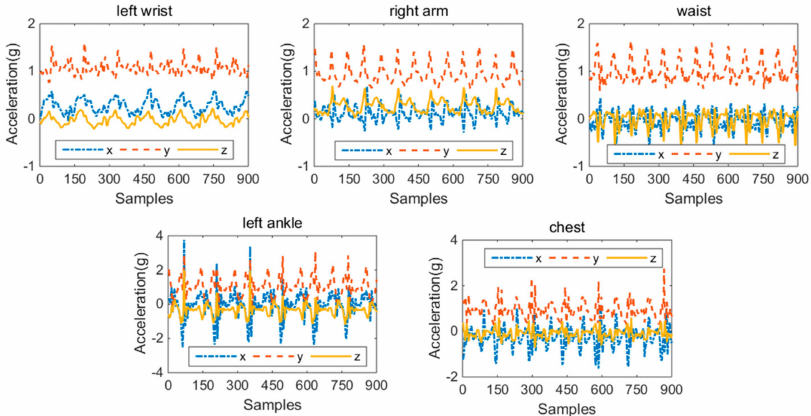
Figure 5. The triaxial accelerometer data of “walking” from the chest, waist, left wrist, left ankle and right